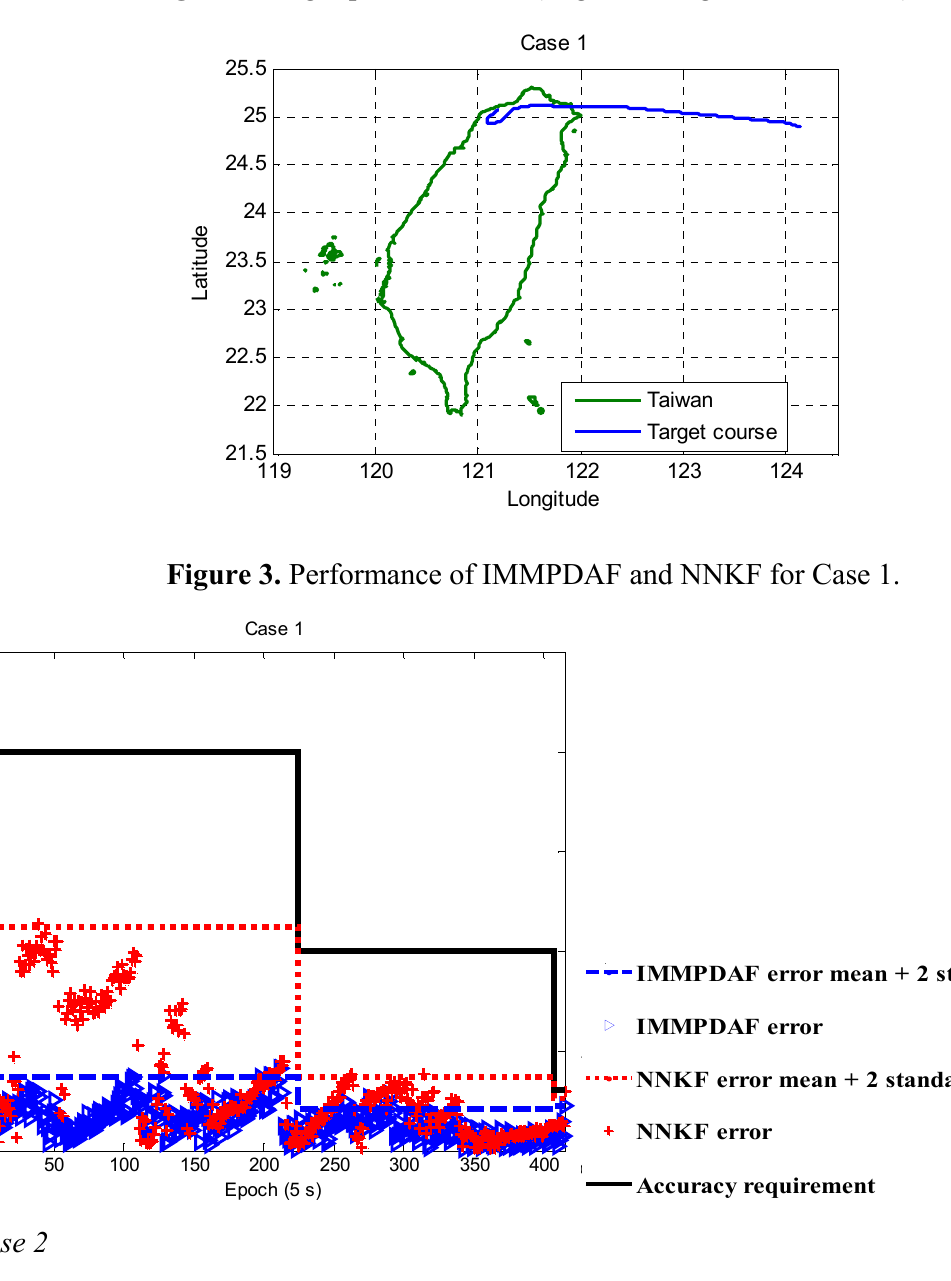
Figure 2. Flight path for case 1 (target heading toward Taiwan).